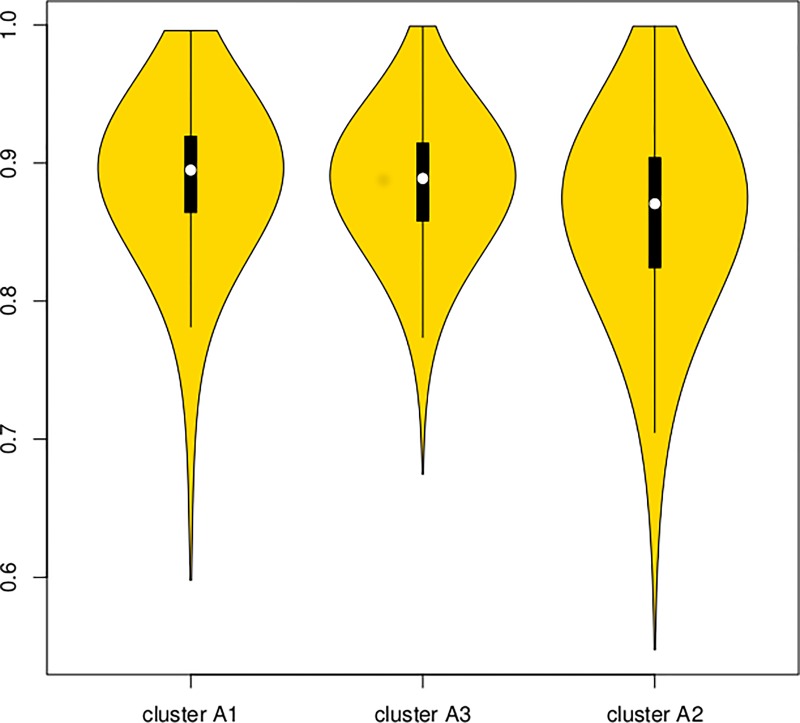
Violin plots of the median AUC based on 300 randomly selected training and testing sets for probes used for hierarchical clustering.The boxplots present median and quartiles. The leftmost violin corresponds to the 'pure T1' cluster, the center corresponds to 'pure T3' and the rightmost to the 'mixed' cluster.